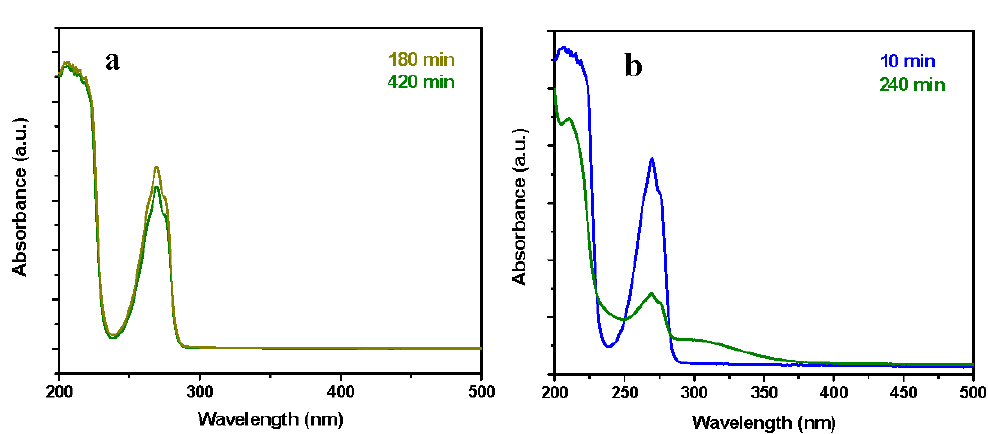
Figure 8. UV-spectra of the reaction media (reaction solutions at specific times) at 95 °C, 4000 mg/L phenol concentration, 0.4 g/L of HCL resin ( a ) and HCL nanocomposite ( b ).